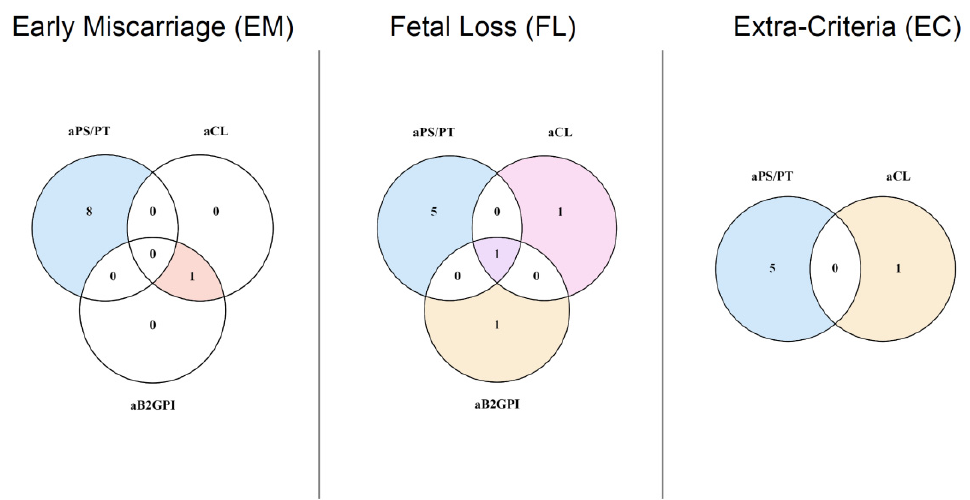
Figure 2. Venn diagrams of overlapping and isolated aPS/PT over criteria aPL. The number of women positive for aPS/PT, aCL and aB2GPI in each one of the groups in which patients were categorized is shown in this figure. LA is absent from this figure because none of our patients resulted in positive values. aPS/PT was mainly found in patients negative for criteria aPL.